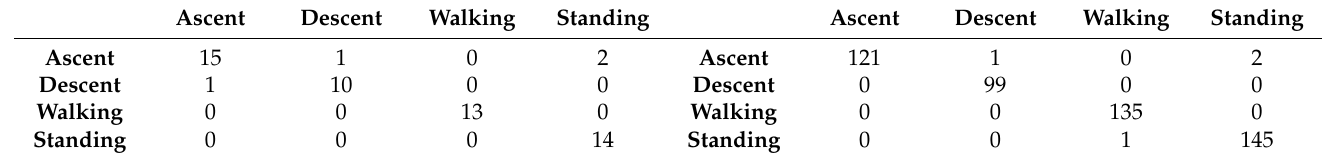
Table 12. Confusion matrix of PD local dataset– MobileNet-v2 (initial results—left, final